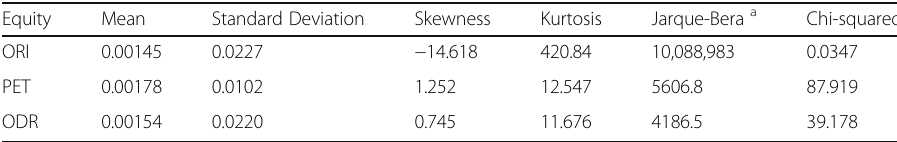
Table 1 Descriptive statistics of the equity log returns